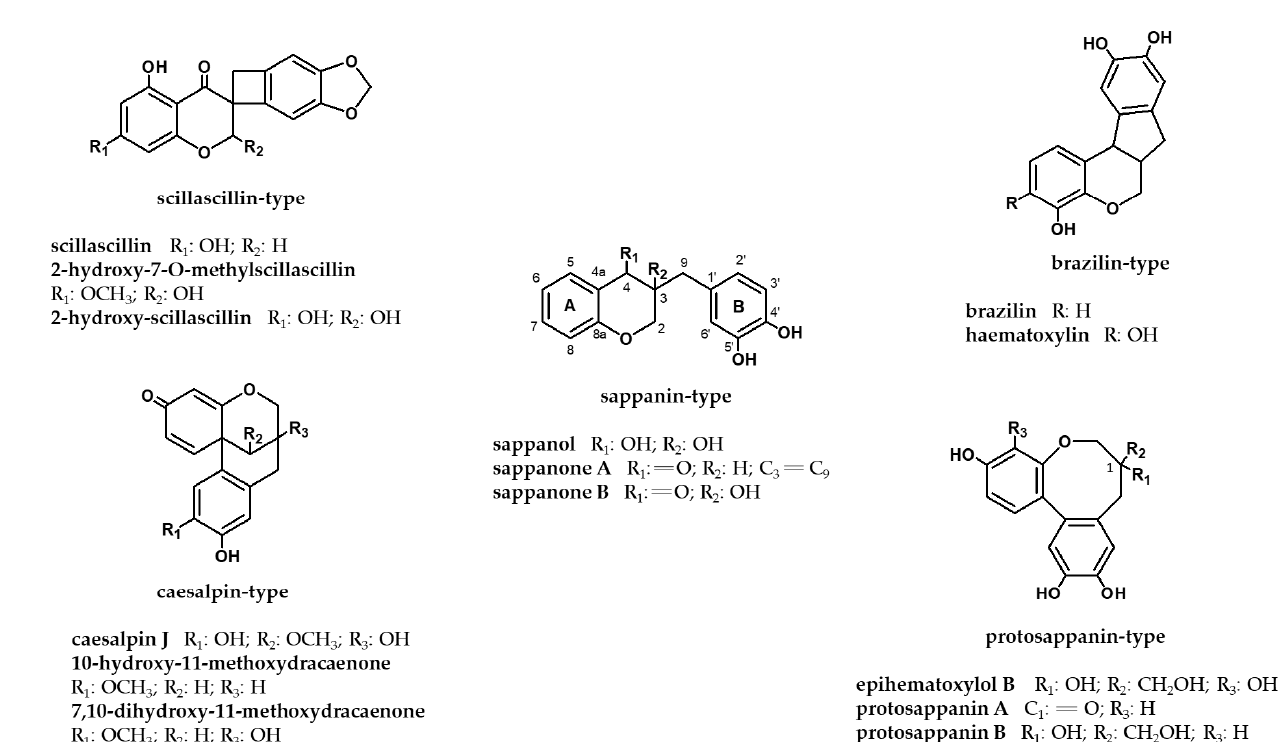
Figure 1. Homoisoflavonoid classification with some representatives.